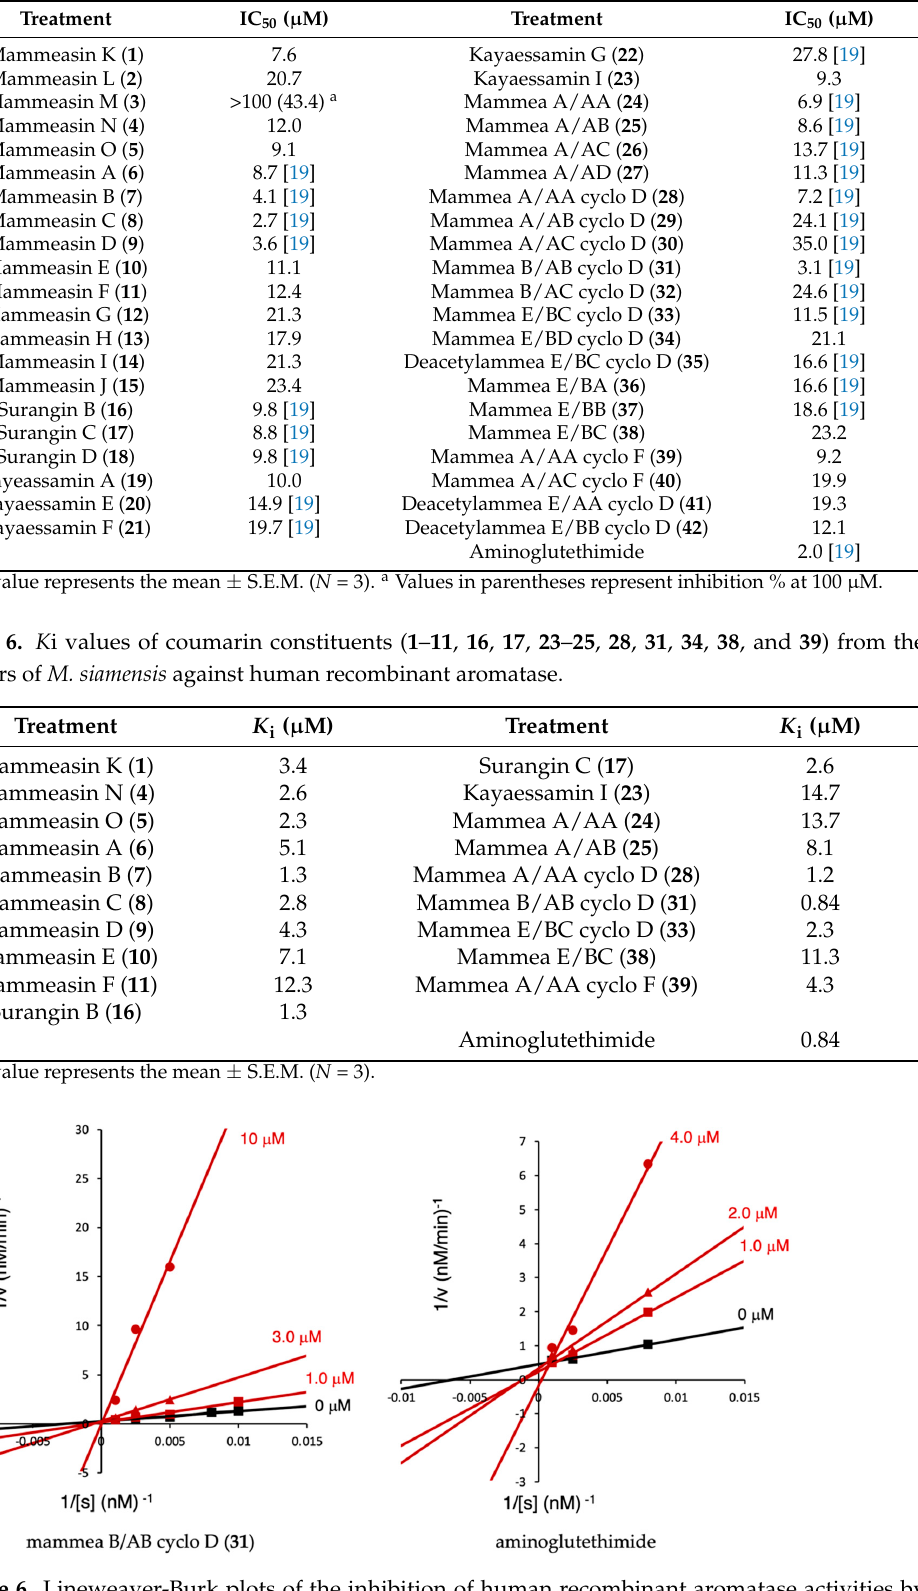
Figure 6. Lineweaver-Burk plots of the inhibition of human recombinant aromatase activities by mammea B/AB cyclo D ( 31 ) and aminoglutethimode.